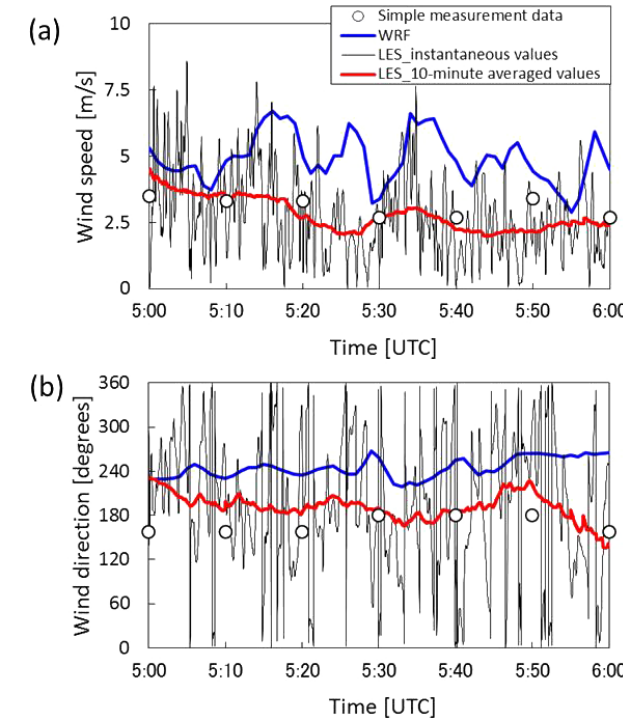
Figure 6. Time series of (a) wind speeds and (b) wind directions obtained at Main gate from 05:00 to 06:00UTC 12 March 2011. The observed and LES data are obtained at the ground-level. The WRF data are obtained at the height of 50m. The location of Main gate is shown in Fig.